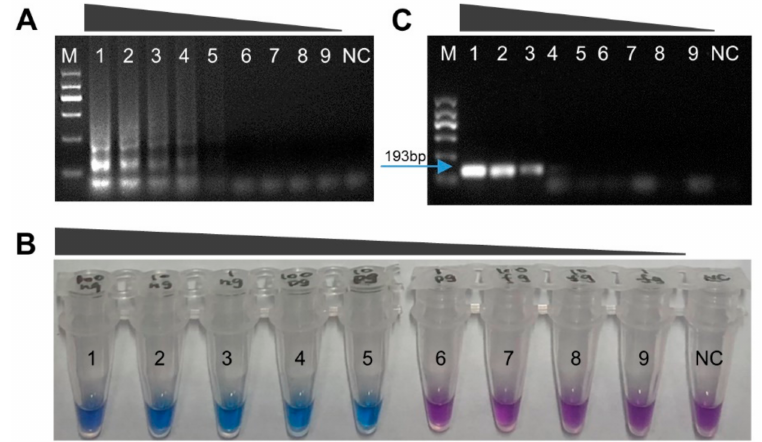
Figure 4. Sensitivity of the LAMP and PCR assays for the detection of M. brunnea . ( A ) LAMP assay products visualized by agarose gel electrophoresis. ( B ) LAMP assay products visualization by hydroxy- naphthol blue (HNB). ( C ) PCR assay products on agarose gel. M = molecular size ladder. Lanes and